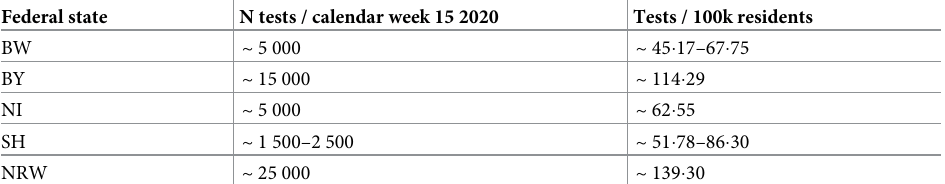
Table 3. Number of tests submitted by 177 laboratories voluntarily in calendar week 14 (06.04–12.04.2020, source: RKI).